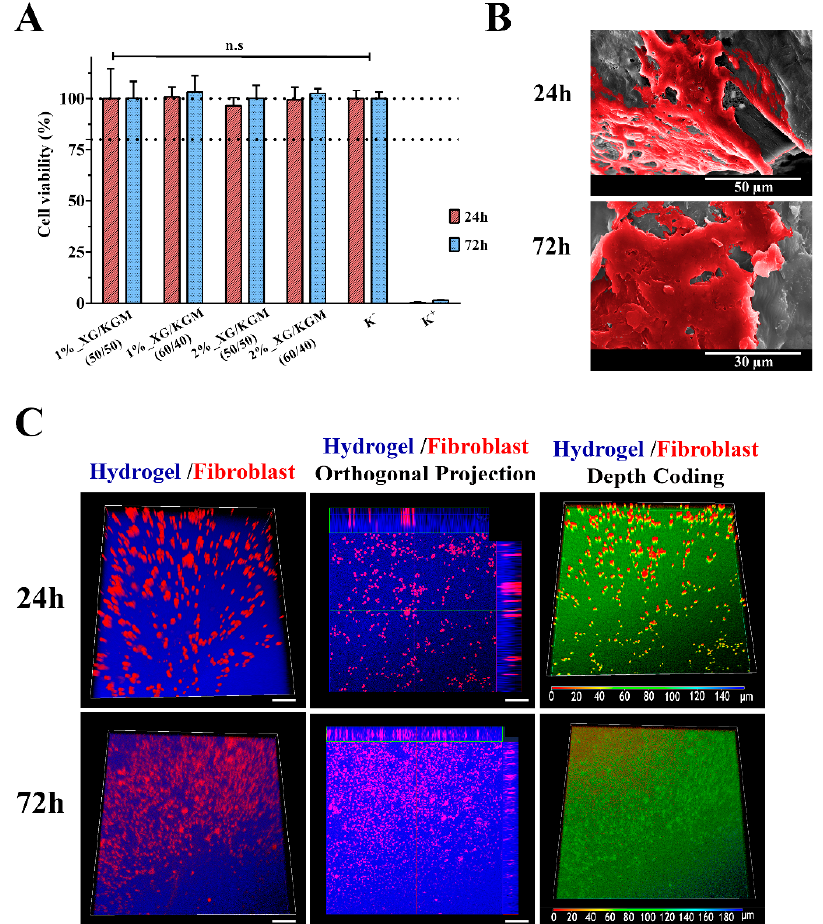
Figure 6. Characterization of the cytocompatibility of the hydrogels. ( A ) MTT assay of human fibroblast cells grown in the presence of di ff erent hydrogels. Wells treated with ethanol were used as positive controls. n.s: no statistically significant groups. The data are shown as means ± standard deviations ( n = 3). ( B ) Representative SEM images of fibroblast cell adhesion and proliferation on the surface of the 1%_XG / KGM_(60 / 40) hydrogel, after 24 h and 72 h of incubation. ( C ) Confocal laser scanning microscopy (CLSM) images of cell internalization in 1%_XG / KGM_(60 / 40) after 24 h and 72 h, where di ff erent colors correspond to distinct depth values (as indicated in the color-coding scale).